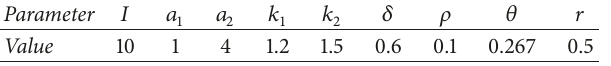
Table 3: Parameter value of 𝐼 , 𝑎 1 , 𝑎 2 , 𝑘 1 , 𝑘 2 , 𝛿 , 𝜌 , 𝜃 , 𝑟 .